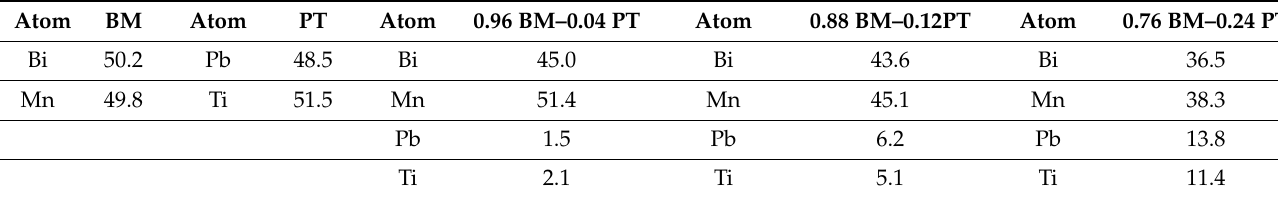
Table 1. Exemplar atomic concentration (at%) estimated for chosen ceramics